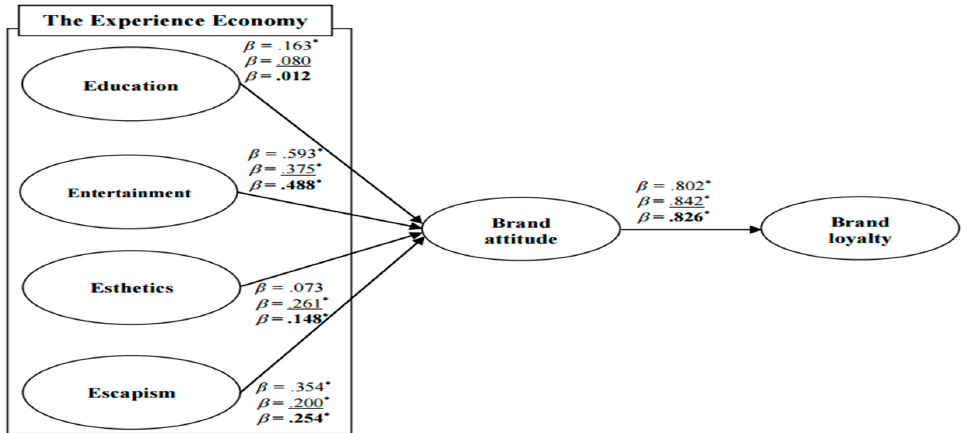
Figure 2. Standardized theoretical path coefficients. RR: χ 2 = 339.823, df = 124, χ 2 /df = 2.741, p < 0.001, NFI = 0.934, CFI = 0.957, TLI = 0.946 and RMSEA = 0.078. RH: χ 2 = 447.945, df = 124, χ 2 /df = 3.612, p < 0.001, NFI = 0.906, CFI = 0.930, TLI = 0.914 and RMSEA = 0.094. MTD: χ 2 = 641.782, df = 124, χ 2 /df = 5.176, p < 0.001, NFI = 0.935, CFI = 0.947, TLI = 0.935 and RMSEA = 0.084. Notes 1: RR = a